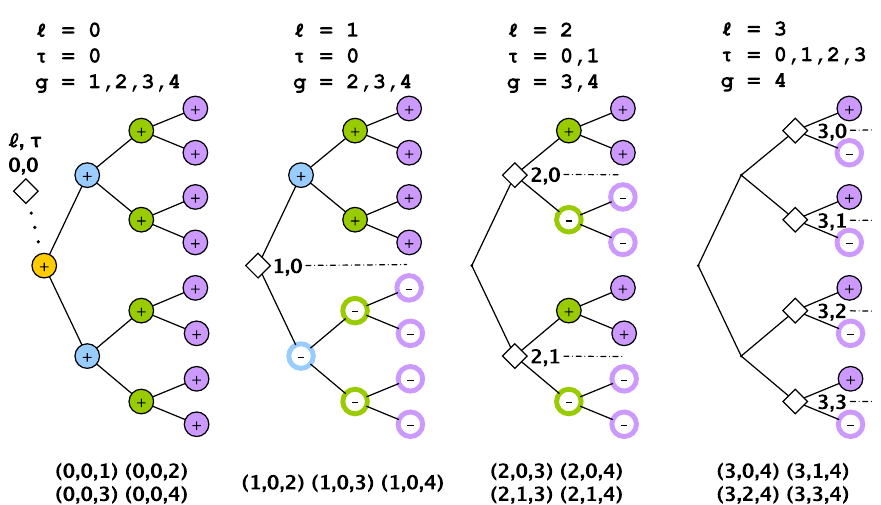
Fig 6. Construction of the natural variables for a tree with 4 generations. Each natural variable is identified by a source of variation ( ℓ , τ ), corresponding to the root of a subtree, and a generation g . The + and − at each lineal position illustrate how the original variables are combined to form a natural variable. The 15 natural variables thus defined by the 3-tuple ( ℓ , τ , g ) are listed in the bottom row. Since the τ coordinates are indistinguishable, only 10 of the natural variables (those with τ = 0, say) are unique.